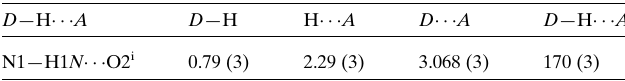
Table 2 Hydrogen-bond geometry (A˚ , (cid:4) ) for (II).